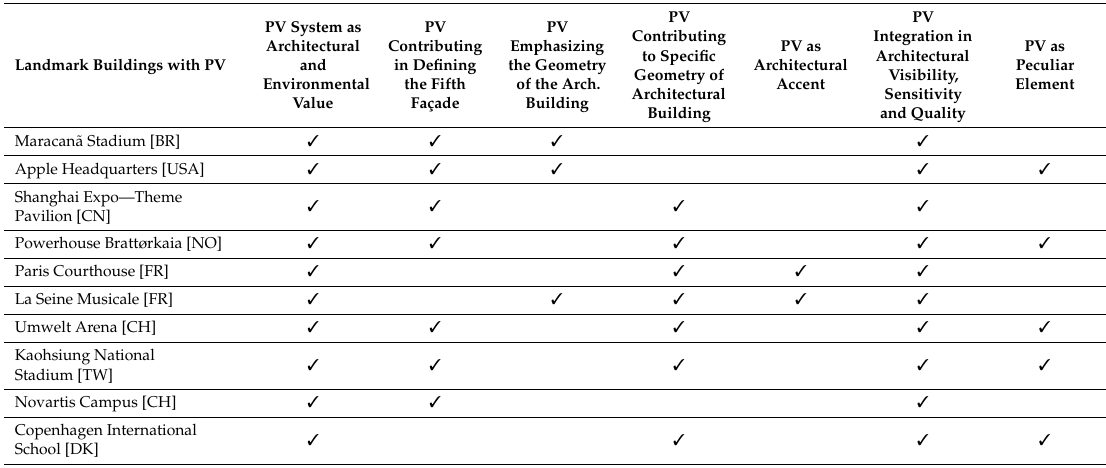
Table 3. Architectural performance of the examined sample